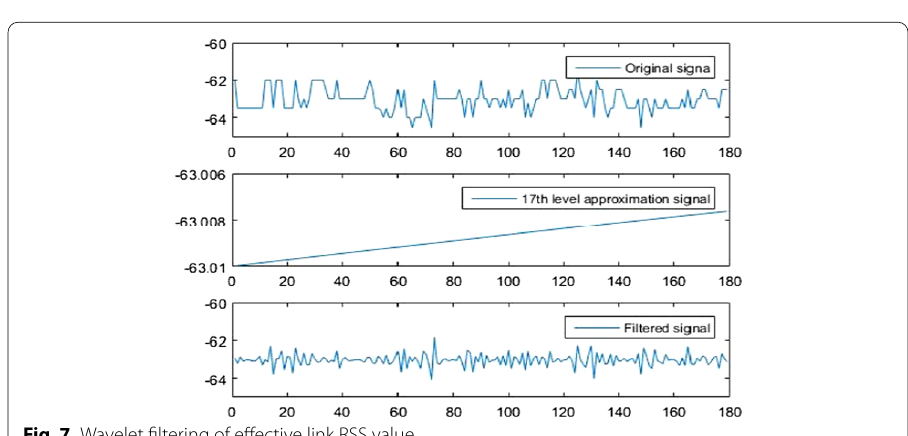
Fig. 7 Wavelet filtering of effective link RSS